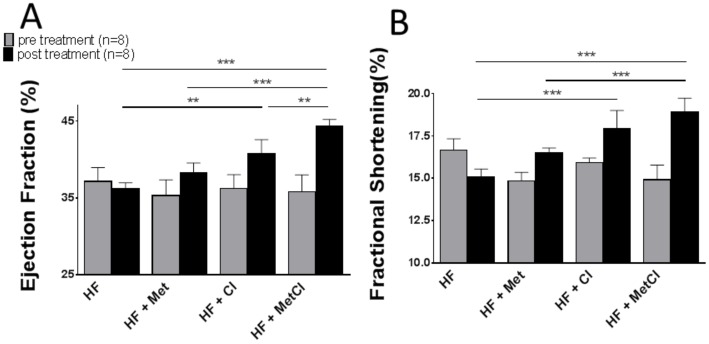
Effect of Cl, Met and combined MetCl therapy on contractile function in non-transplanted failing hearts, EF (A) and FS (B): No difference in baseline values in treatment groups was seen (light grey bars).Average values at end of treatment period are shown (black bars): Cl-treated group showed improved EF and FS compared to untreated HF group, and improvement in EF was further enhanced in MetCl group. Met-induced improvement in EF and FS was not statistically significant. ***P<0.001 (n = 8 per group).